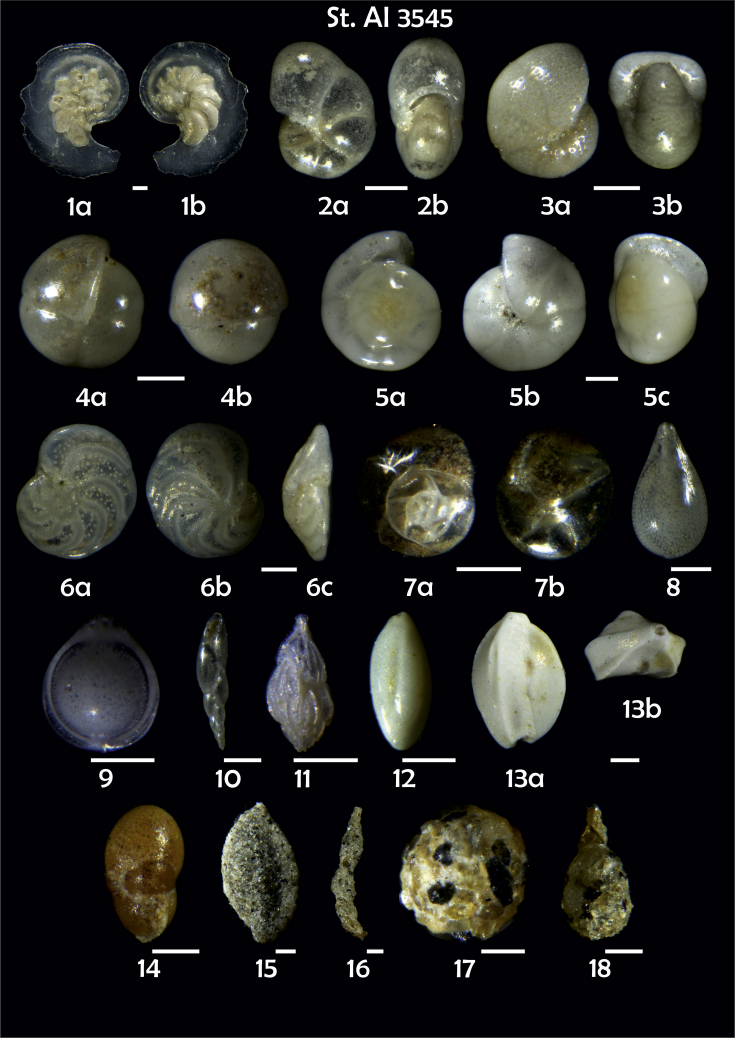
Station 35451Laticarinina pauperata. 2Pullenia sp., a lateral view, b apertural view. 3Melonis pompilioides, a side view, b apertural view. 4Pullenia bulloides, a side, b apertural view. 5Hansenisca soldanii,a spiral view, b umbilical view, c apertural view. 6Cibicidoides wuellerstorfi,a umbilical view, b spiral view, c apertural view. 7Epistominella exigua, a spiral view, b umbilical view. 8Lagena sp. 9Fissurina sp. 10Fursenkoina complanata. 11Trifarina angulosa; 12Triloculina elongata13Quinqueloculina sp. cf. Q. arctica, a lateral view, b apertural view. 14Cystammina pauciloculata. 15Sigmoilopsis schlumbergeri. 16Reophax dentaliniformis?. 17Psammosphaera fusca. 18Lagenammina difflugiformis. Scale 100 μm.